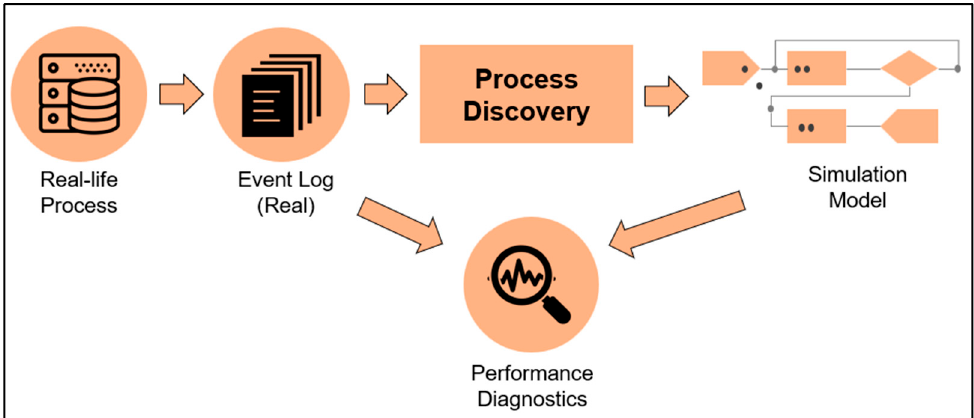
Figure 2. Integrating process mining and simulation for performance analysis.